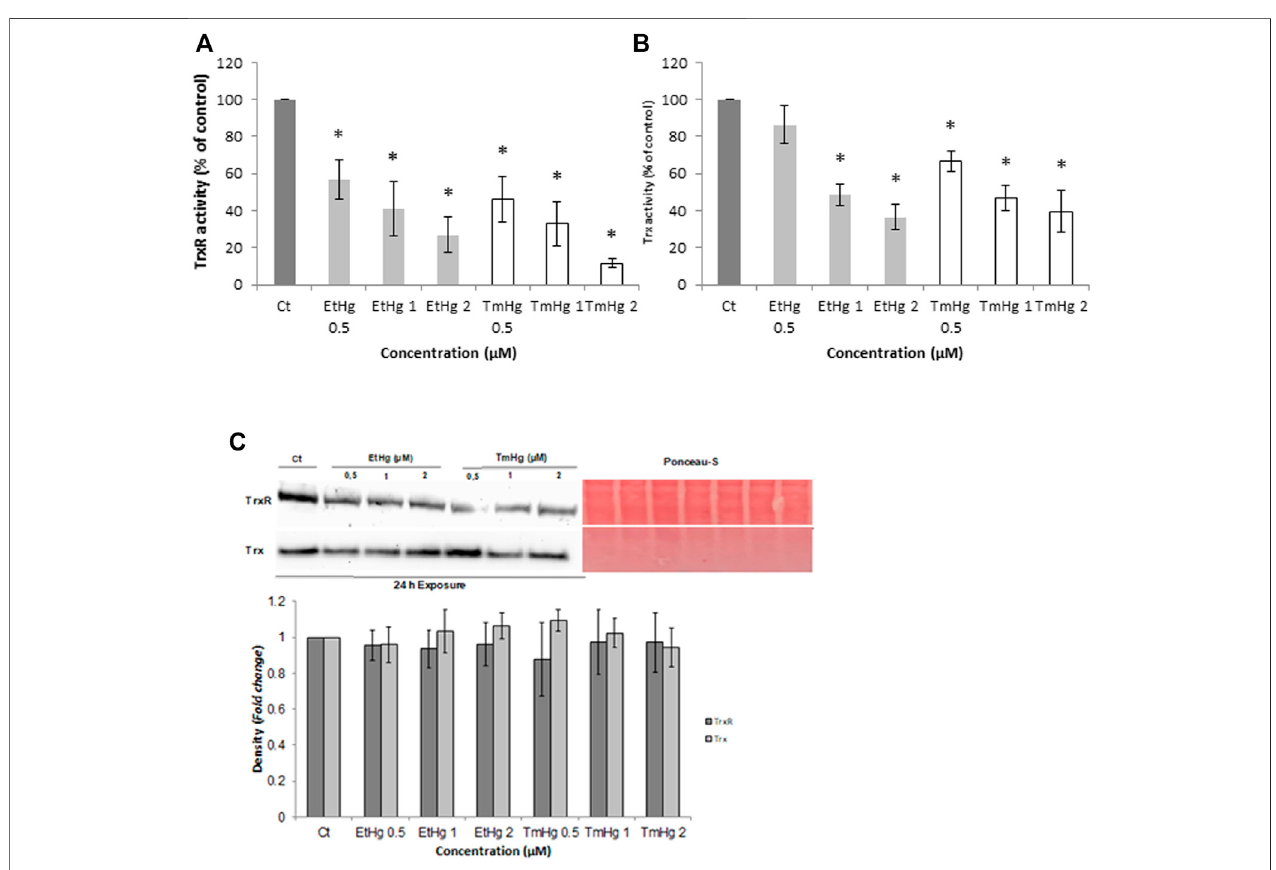
FIGURE2| EffectofTmHgand EtHg onTrxR (A) and TrxActivity (B) and Expression (C) .Cells wereexposed tomercurycompounds (0; 0.5;1and 2 µM)for24 h and enzymatic activity was measured by the insulin end-point assay in total cellular lysates. Expression levels were determined by Western Blot and results were normalized for protein loading with Ponceau-S (C) . Data in A and B are expressed as activity relative to the non-treated control. Values are the mean ± SEM of three to four independent experiments. p p < 0.05 from non-treated control.